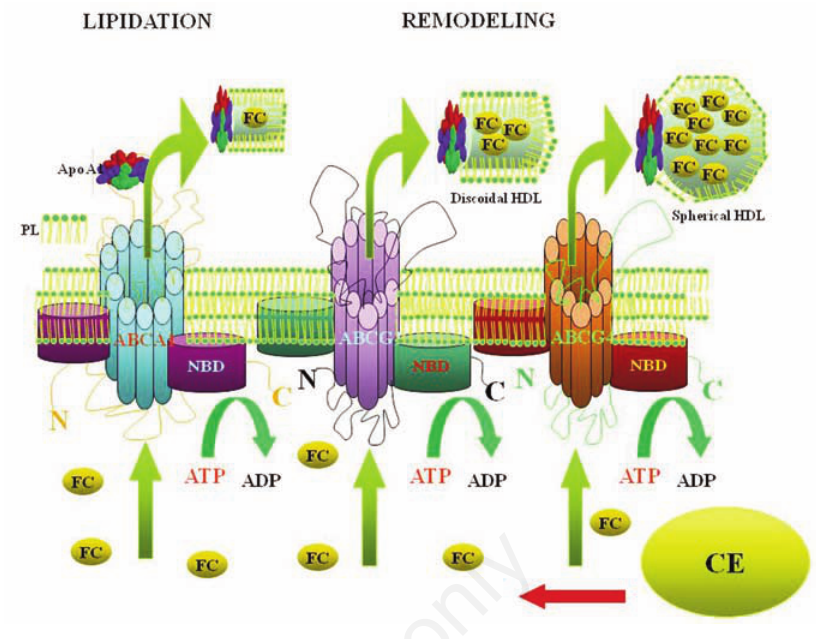
Figure 1. High-density lipoprotein (HDL) particles start out as apolipoproteins produced by the liver, called apoA1. Precursor molecules are released in HDL called pre-B-HDL, incorporating small quantities of cholesterol and lipids, especially phospholipids (PL). ATP-binging cassette transports (ABC) proteins transport various molecules across extra- and intra-cellular membranes. Cholesterol from non-hepatic peripheral tissues is trans- ferred to HDL by the ABCA1. ABCG1 and ABCG4 are necessary for the further lipida- tion required becoming spherical particles HDL. The free cholesterol (FC) is converted to cholesteryl esters (CE) by the enzyme lecithin-cholesterol acyltransferase (LCAT).